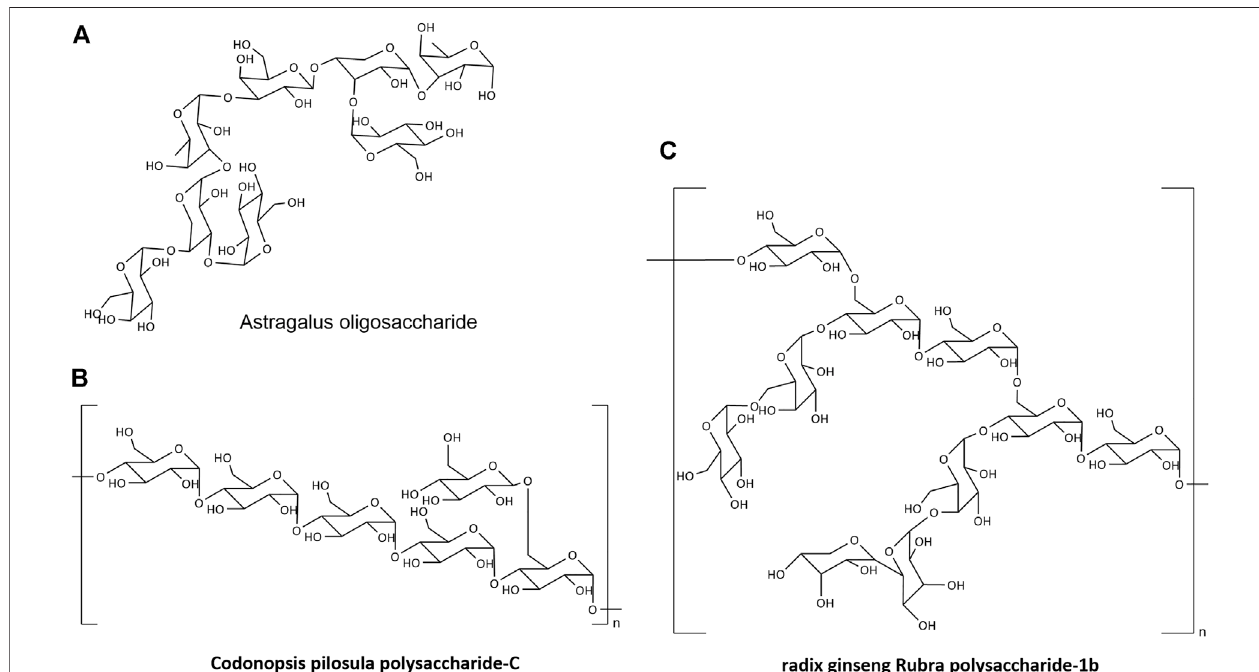
FIGURE 2 | The structure of